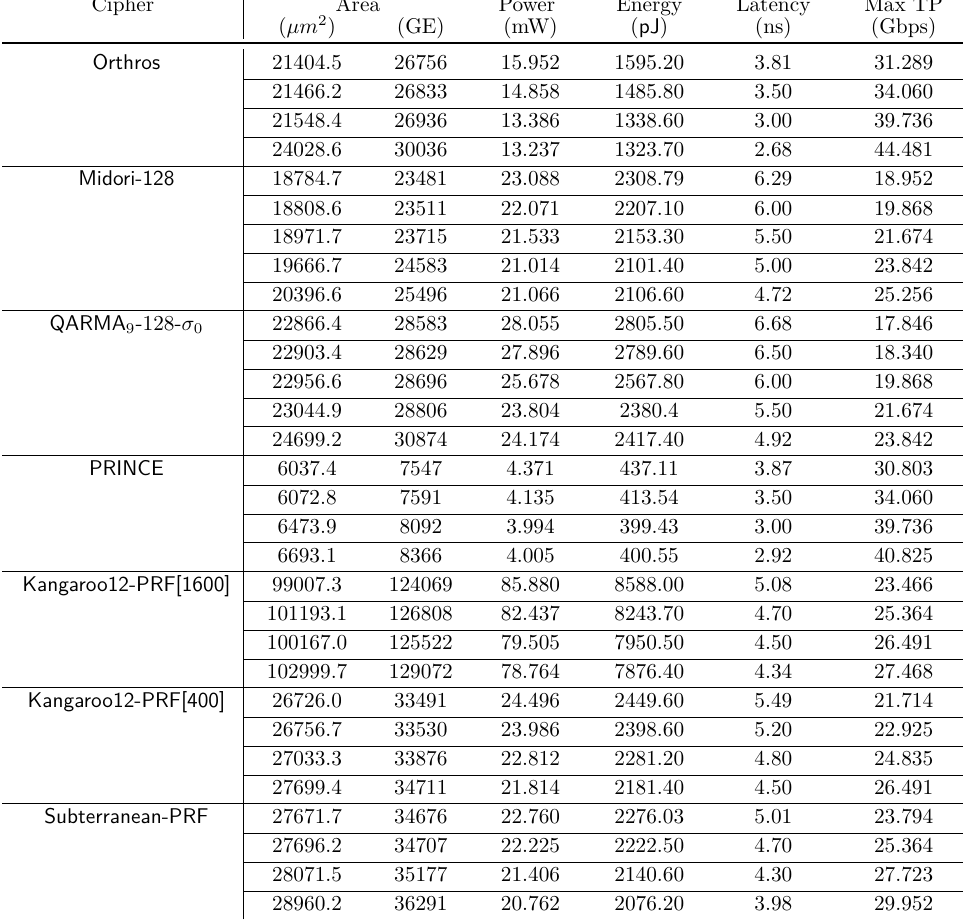
Table 19: Results for the Nangate 45nm library. Power measured at 10